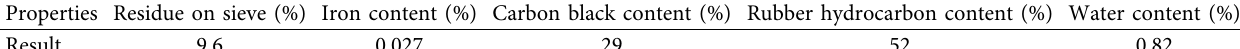
Figure 2: Relevant physical and chemical properties of rubber powder. (a) The micrograph of rubber powder. (b) The elemental energy spectrum curve. Table 1: Main physical indexes of rubber powder.